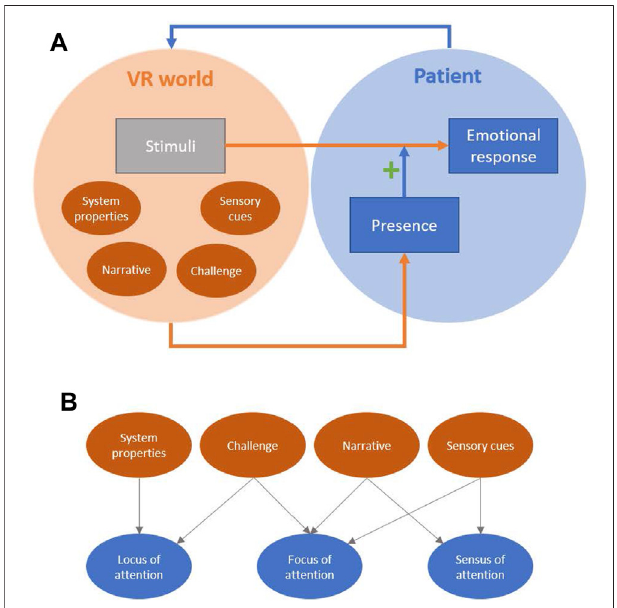
FIGURE 1 | Schematic overview of virtual reality exposure therapy (VRET), in which trauma-relevant stimuli are presented in a VR environment that isenriched withimmersivedesign aspects (dark orange circles) (A) These aspects can affect presence as experienced by the patient, which can moderate their emotional response to the stimuli (B) The design aspects in fl uence presence through their effects on different attention-based